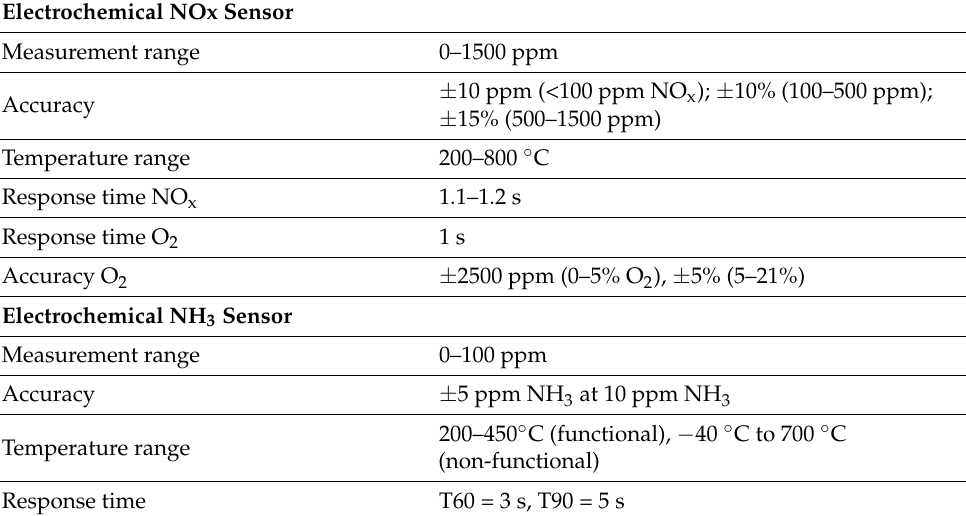
Table 3. Properties of the SEMS system NO x , O 2 , and NH 3 sensors.